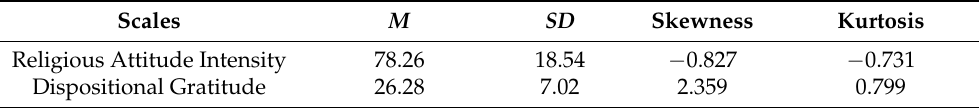
Table 1. Descriptive statistics for the Scale of Religious Attitude Intensity and the Gratitude Ques- tionnaire (N = 189).